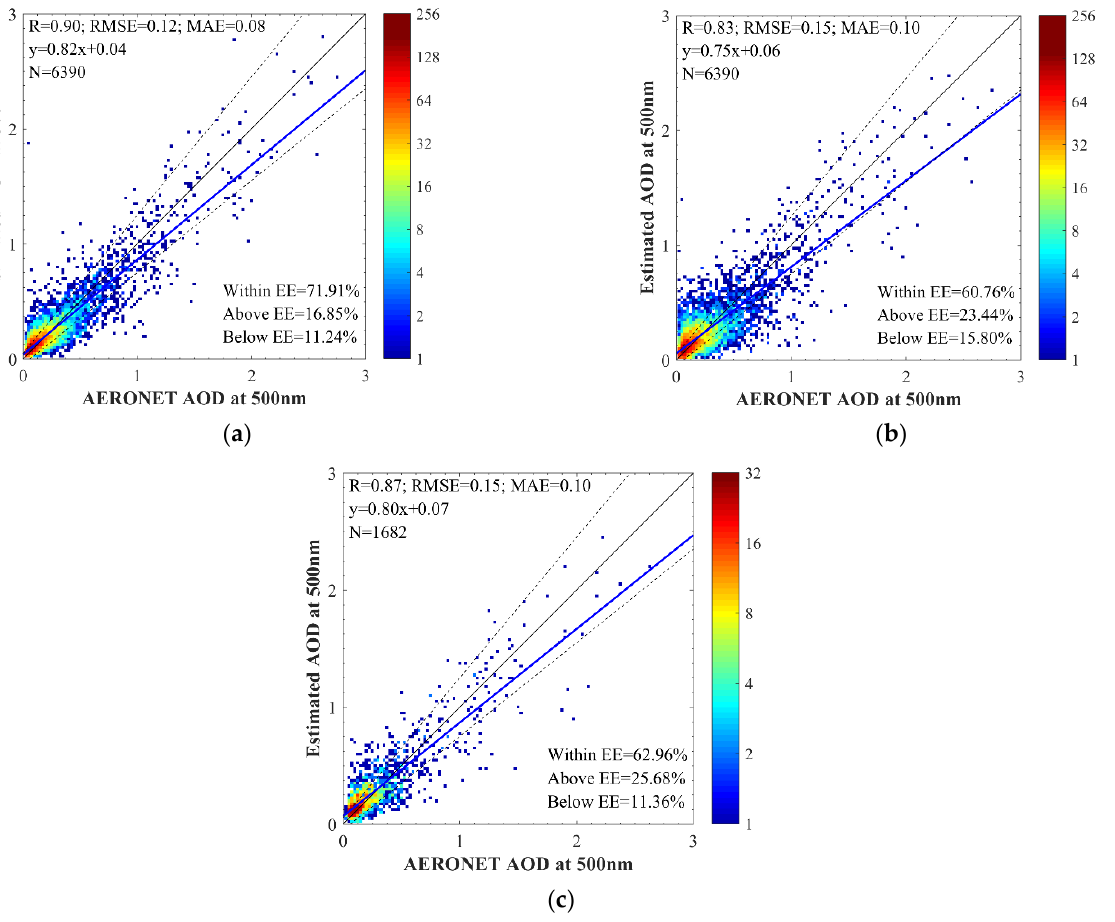
Figure 3. ( a ) k -fold cross-validation of the DNN estimated 500 nm AOD ( k = 329); ( b ) leave-one- station-out cross-validation of the DNN estimated 500 nm AOD; and ( c ) same as ( b ), but only for urban AEROENTE stations.